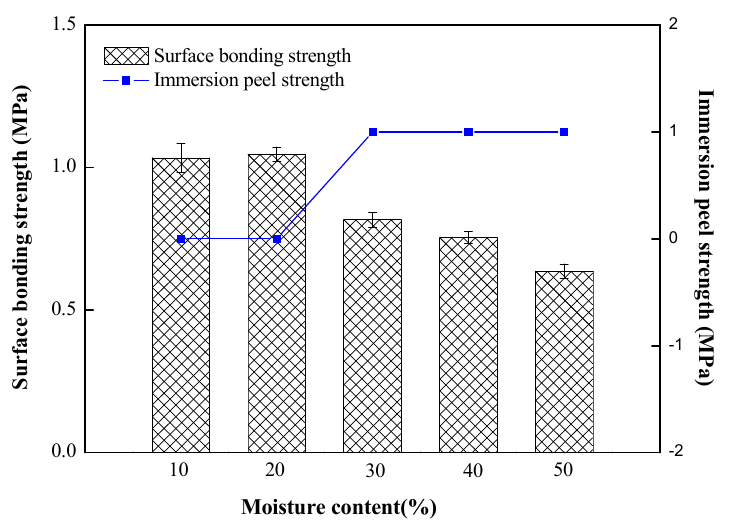
Figure 5. Effects of initial MC on the overlaying performance of PE film reinforced Fraxinus mands- hurica veneer.